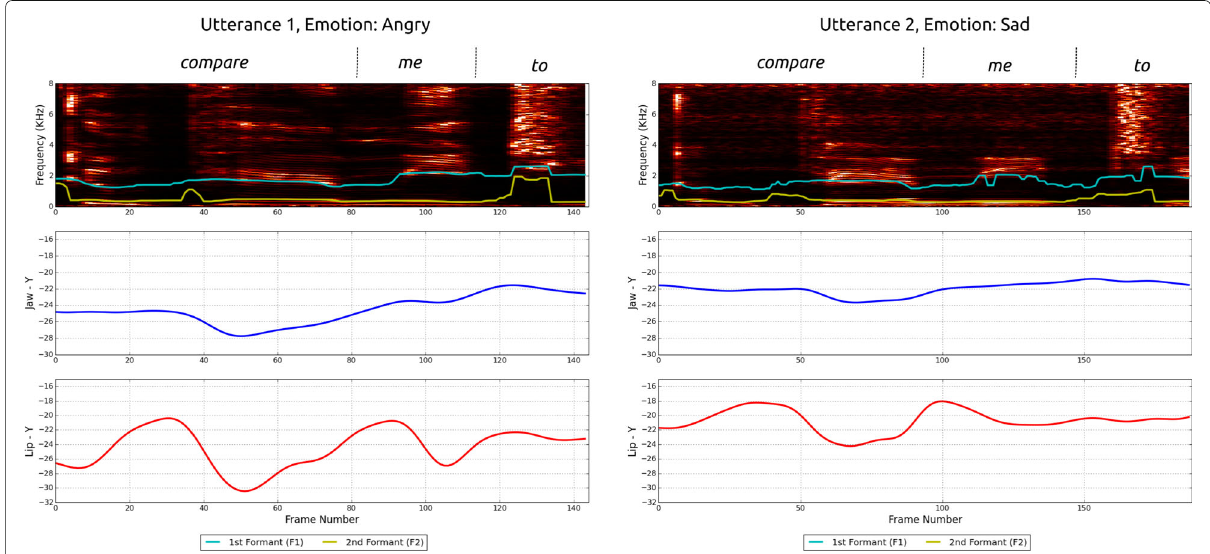
Fig. 1 Relationship between angry (left panel) and sad (right panel) emotions, acoustic characteristics, and articulatory information for an utterance “comparemeto” by a male speaker. (Top row) Spectrogram and formant tracks, (middle row) position of the jaw along Y -axis, and (bottom row) position of the lip along Y -axis. Note the differences in articulatory position and frequency response for vowels /AE/ and /IY/ of words “compare” and “me” , respectively. Negative axis corresponds to downward movement along the Y